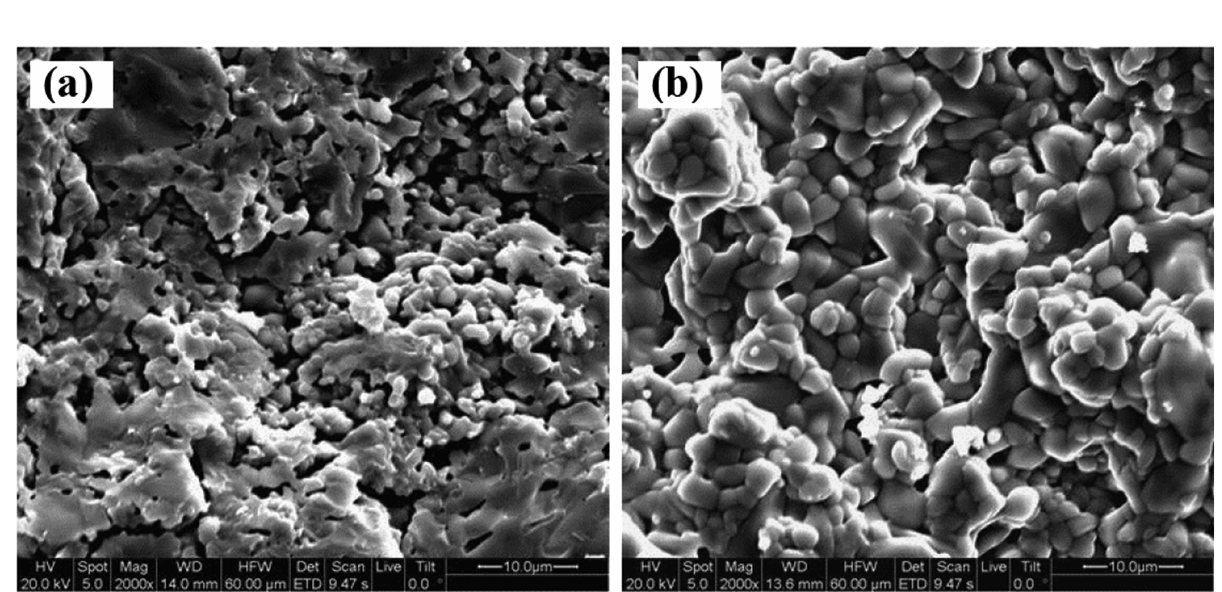
Figure 5: SEM images of the cathode pellets of titanium-rich residue after sintering at 1,100 ℃ for 2 h. (a) Pressure at 3 MPa and (b) pressure at 6